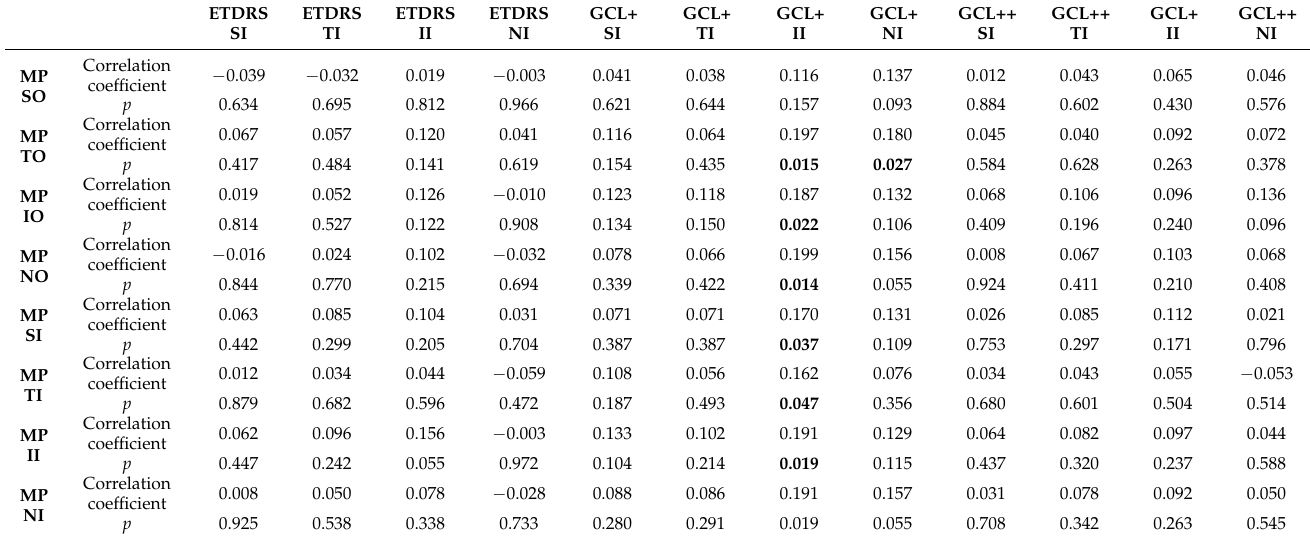
Table 2. Spearman correlations between functional data measured by MAIA in different sectors and anatomic data meas- ured by SS-OCT in the 4 sectors the inner ring according to the total retina protocol, GCL+ protocol and GCL++ protocol. Significant correlations ( p < 0.05) are highlighted in bold print.